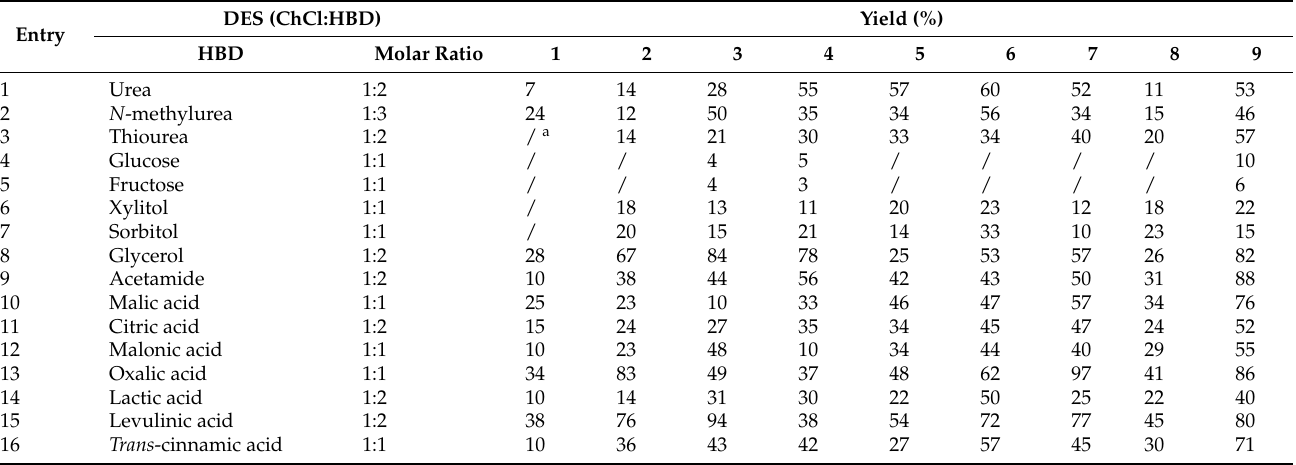
Table 3. Yields ( % ) of the ultrasound method for the synthesis of isonicotinamide quaternary salts ( 1 – 9 ) over 3 h at a temperature of 80 ◦ C.